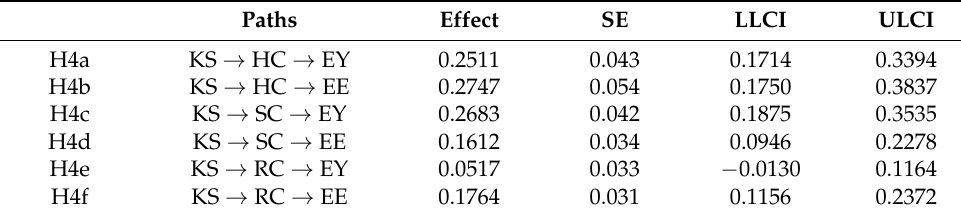
Table 6. Results of the test for mediating effects. Paths Effect SE LLCI